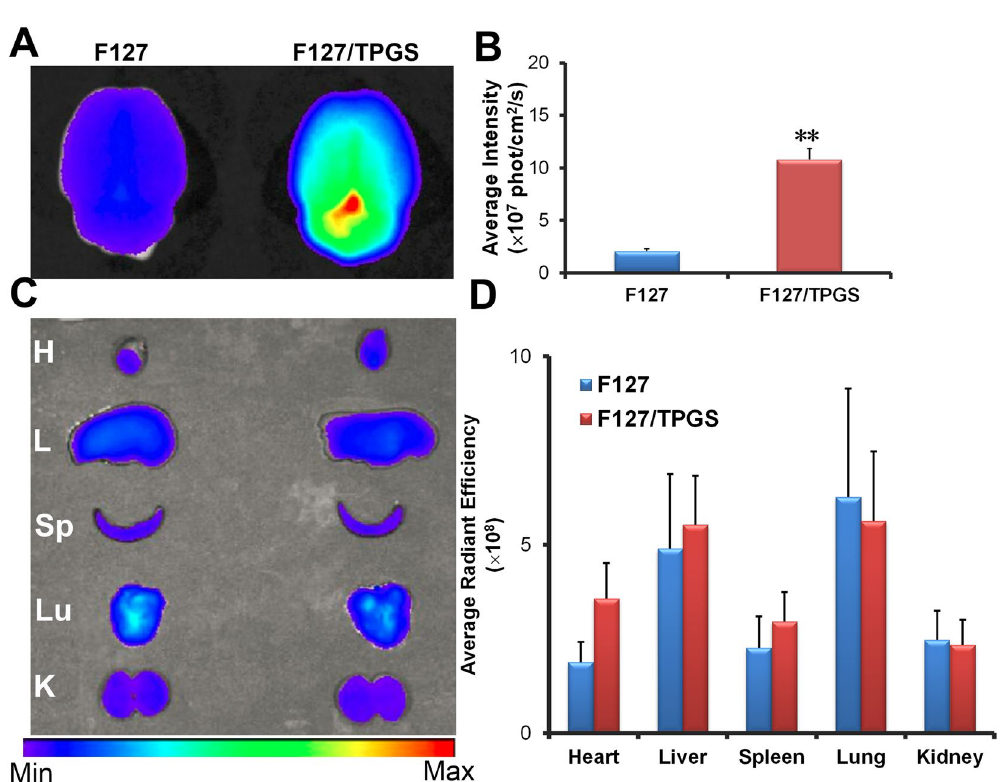
Figure 6. Ex vivo imaging of major organs post DiR-loaded micelles i.v. injection in rats. ( A ) Ex vivo imaging of the brains harvested at 2 h. ( B ) Semi-quantitative fluorescence intensity of brains. ( C ) Ex vivo imaging of other major organs (H: heart, L: liver, Sp: spleen, Lu: lung, K: kidney). ( D ) Semi-quantitative fluorescence intensities of those different organs. Statistically significant differences by t -test when compared to the corresponding value of the control. ** P < 0.01, vs F127 (n =